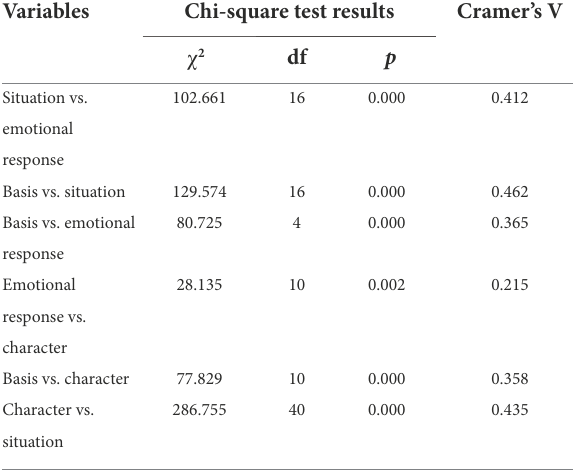
TABLE 6 Chi-square test results and Cramer’s V of variable